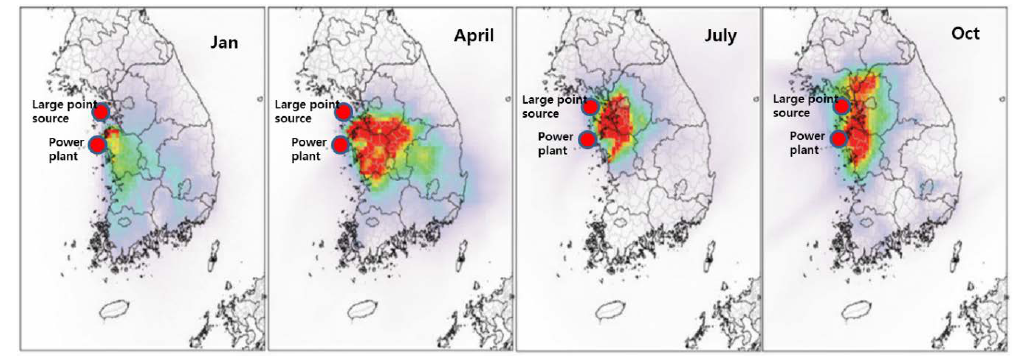
Figure 4. Spatial distributions of the monthly averaged contributions of large point-sources on the monthly PM 2.5 concentration in Chungcheongnam-do (CN), modified from [19] (note: reference year is 2014).